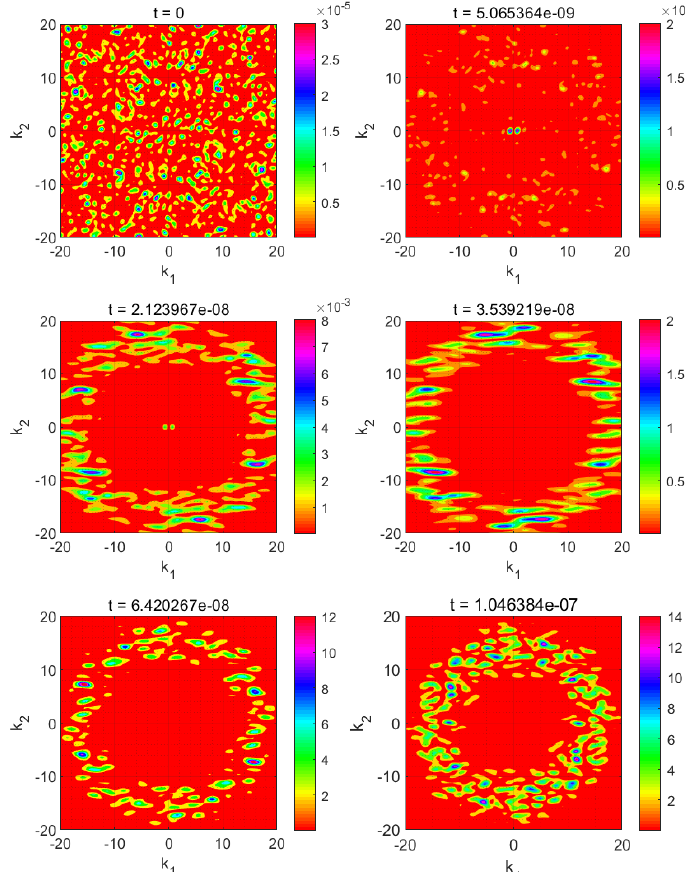
Figure 4. Simulated light scattering patterns obtained for the calculated structure factors for the case where D = 10 5 , c o* = 0.3 and T 1* = 0.34 at x * = 0 and T 2* = 0.30 at x * = 1. The asterisks were left out of the variables k 1 , k 2 , and t in the